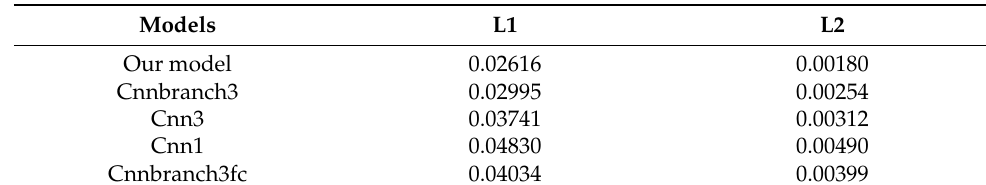
Table 5. Comparison results for Neihuan elevated highway.